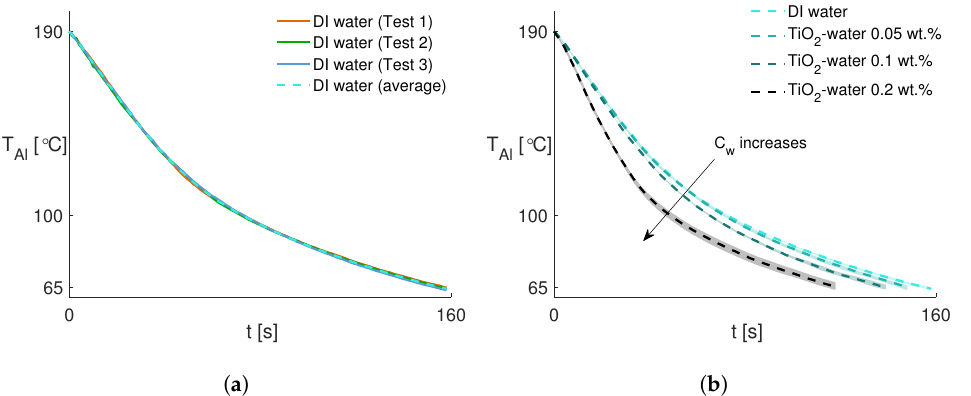
Figure 5. ( a ) Temperature drops in the aluminum block over time for DI water as a repeatability check, including the average profile (dashed line). ( b ) Comparison of the temperature drops in the aluminum block over time for each fluid with uncertainty (shaded